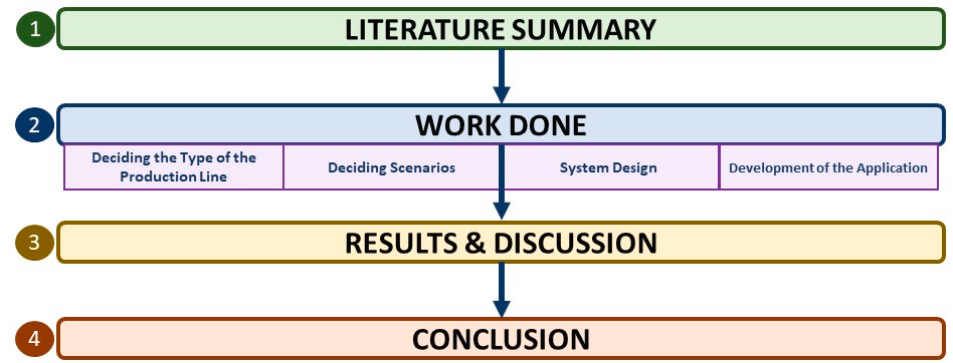
Figure 2. The methodology of the proposed work.